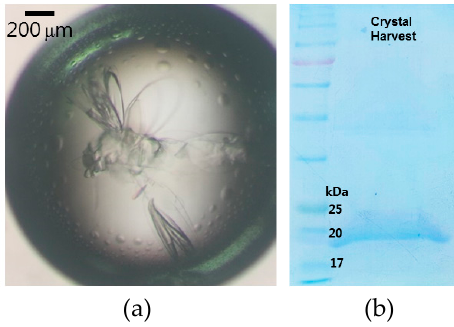
Figure 4. ( a ) Clustered crystals of PCNT CC2 and ( b ) the SDS-PAGE analysis of harvested crystals used for MS analysis of tryptic digestion fragments.